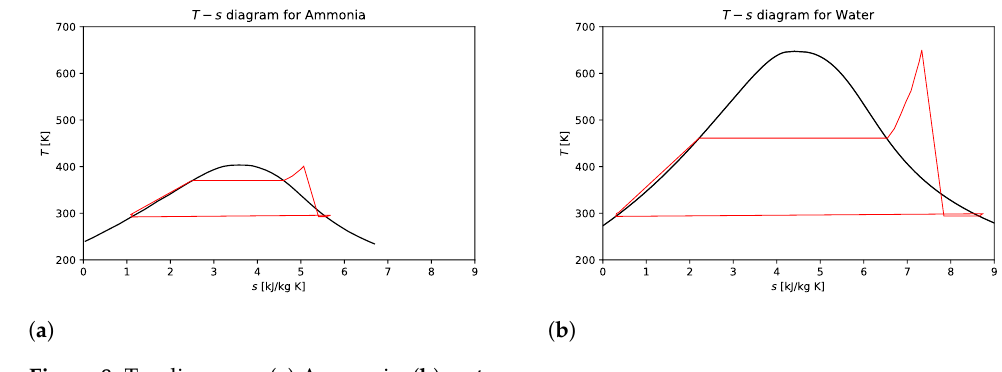
Figure 8. T–s diagrams. ( a ) Ammonia; ( b ) water.